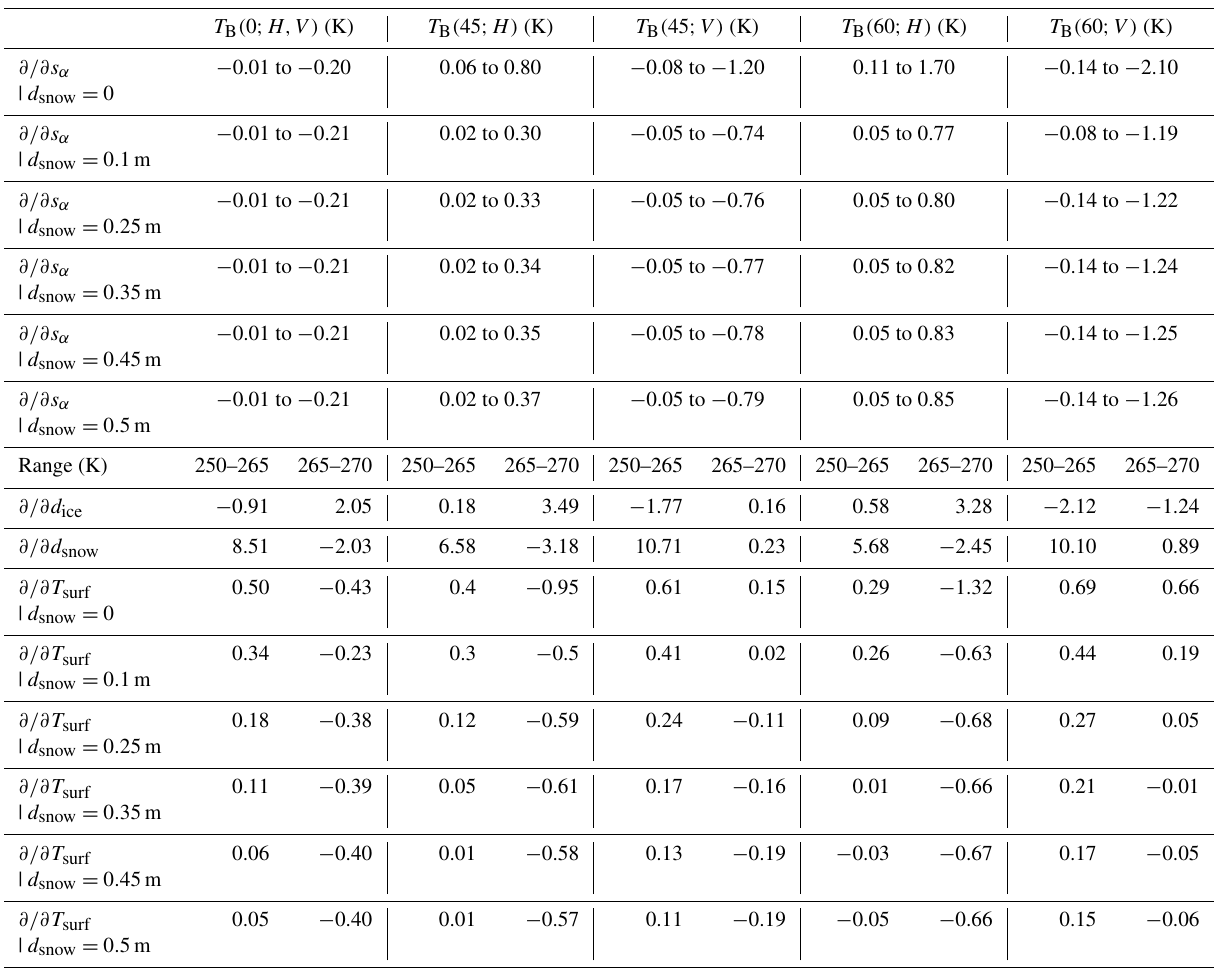
Table 2. Table with sensitivities of the brightness temperature at nadir, 45, and 60 ◦ as simulated with geometrical optics surface roughness model. The input parameters are roughness parameter s alpha , ice thickness d ice , snow thickness d snow , and surface temperature T surf